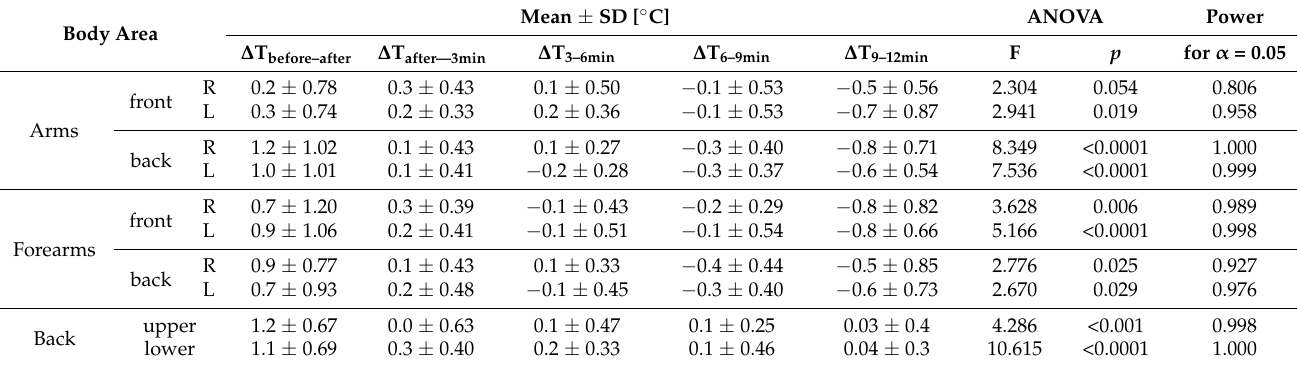
Table 3. Characteristics of changes in mean values ( ± SD) of surface temperature of the assessed areas over time ( ◦ C). Body Area